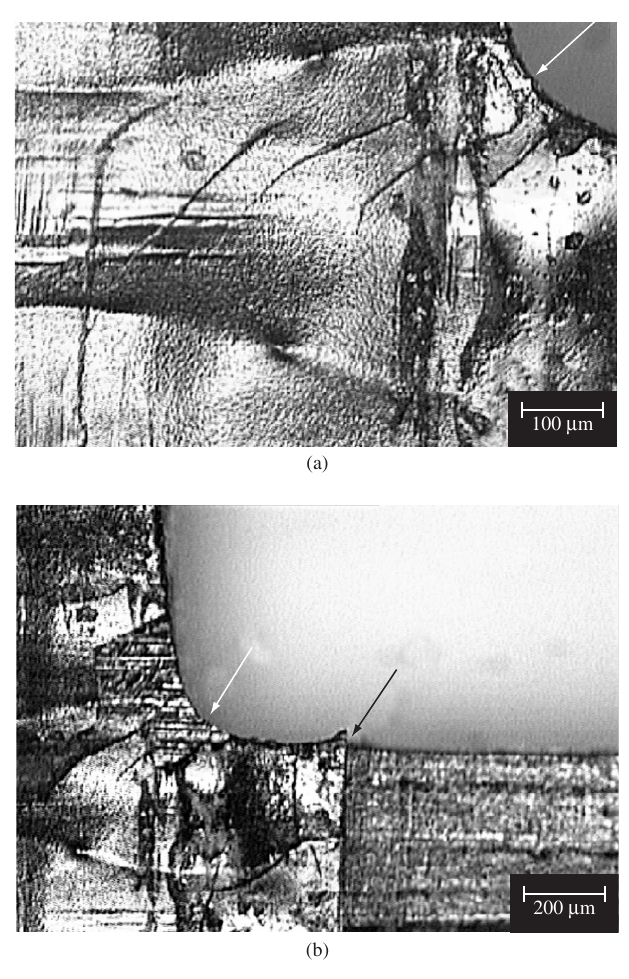
Figure 7. a) Massive fatigue cracking (white arrows) developed at one side of the notch tip of laminate FB180 (specimen D); and b) Opposite-side final fracture (black arrow) of the same